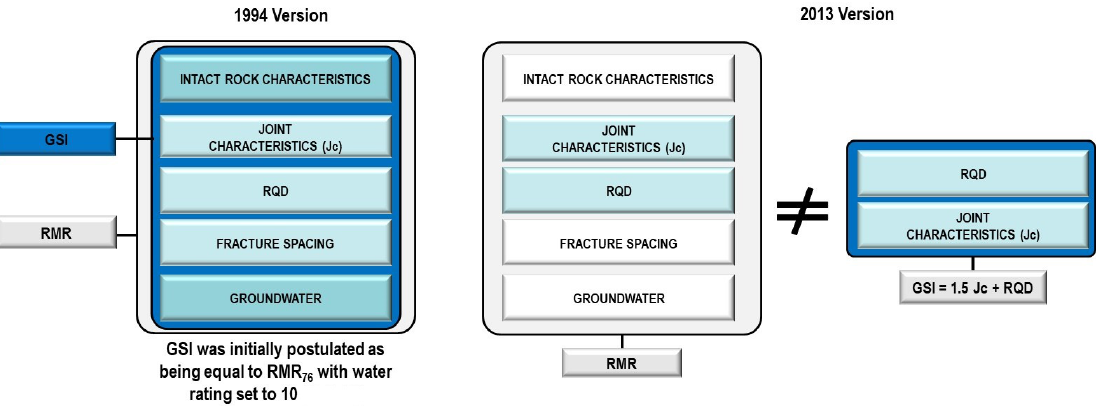
Figure 11. Issue of using empirical correlations between definitions that consider a different number of variables. of